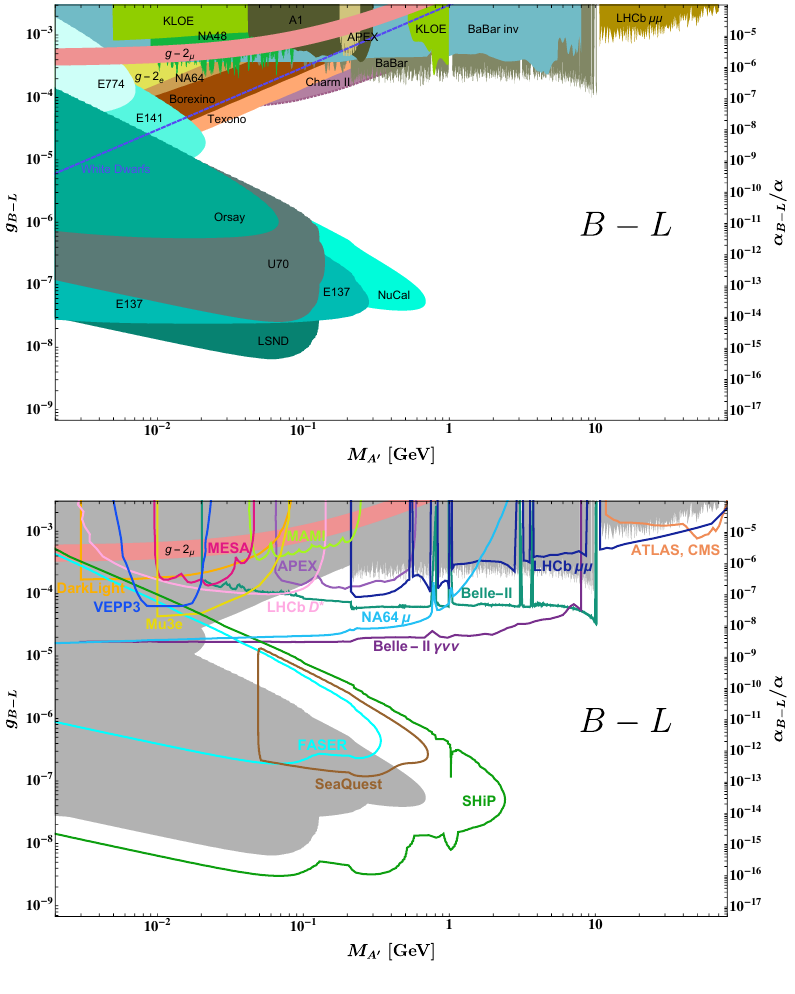
Figure 13 . Constraints from current (upper panel) and future (lower panel) experiments on a U(1) B L gauge boson with gauge coupling g B (cid:0)